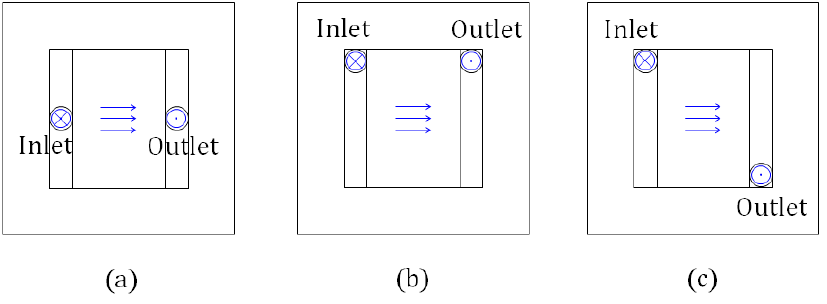
Figure 2. Different inlet–outlet configurations for flow disruption study: ( a ) I-type configuration, ( b ) C-type configuration, and ( c ) Z-type inlet-outlet configuration.